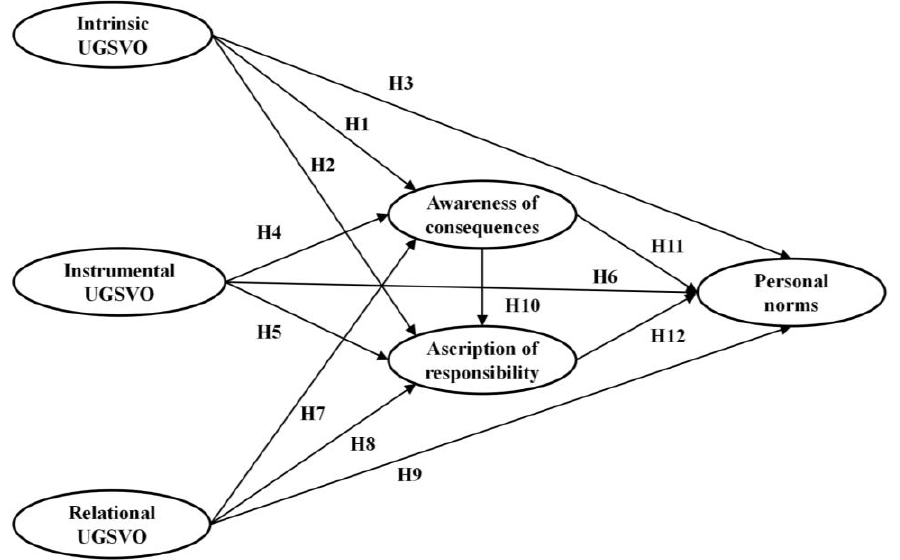
Figure 2. Hypothesized relationships among the constructs.